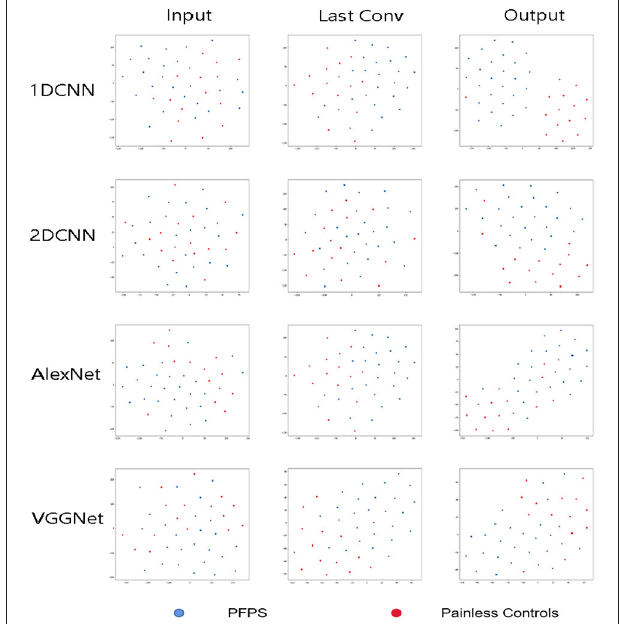
FIGURE 8 | Visualization of feature representations extracted from input layer, last convolutional layer and output layer for running data